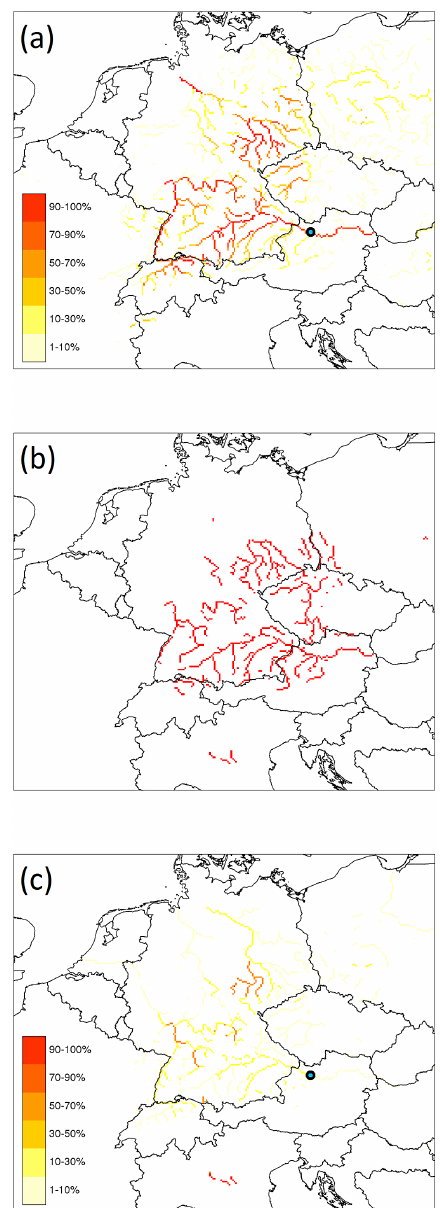
Figure 10. Maximum exceedance of the 5-year return period be- tween 30 May 2013 and 9 June 2013 for (a) ERI forecasts, (b) EFAS-WB, and (c) EFAS forecasts. The location of Linz is shown with a blue